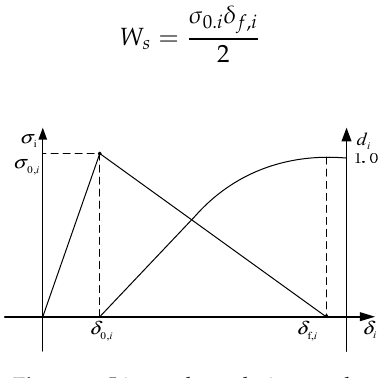
Figure 8. Linear degradation mode.